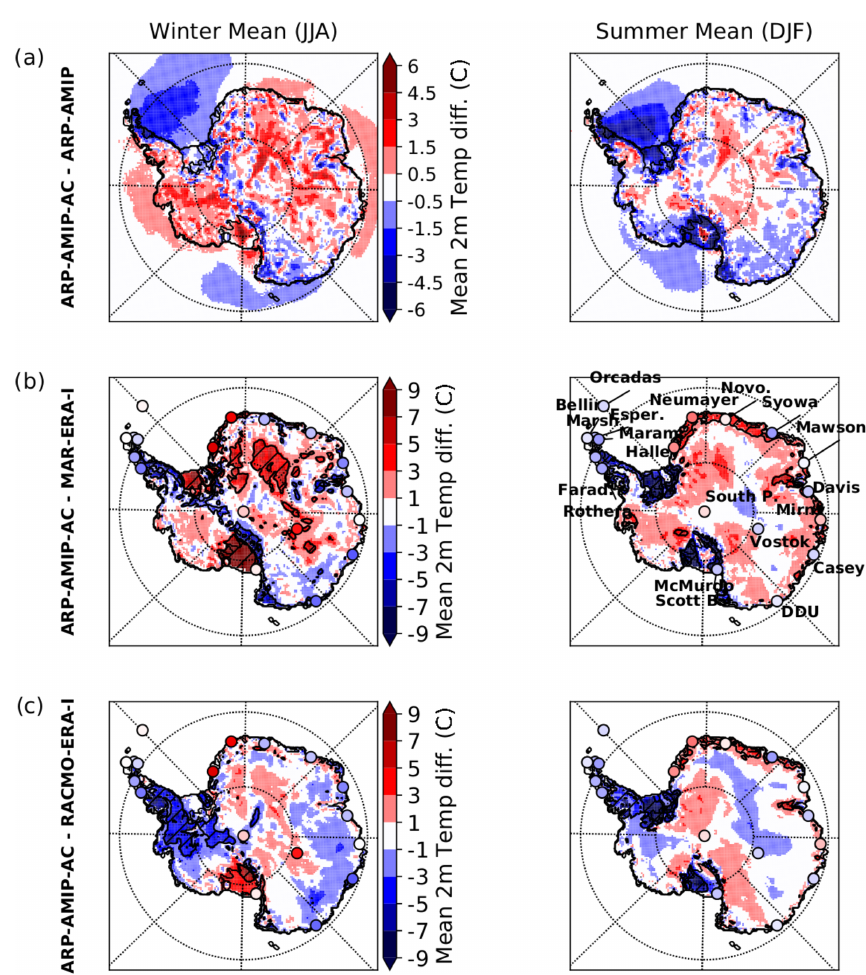
Figure 4. (a) ARP-AMIP-AC minus ARP-AMIP T 2m in winter (left) and summer (right). (b) Same as panel (a) but for ARP-AMIP-AC minus MAR-ERA-I. Circles represent mean bias for weather stations from the monthly READER database. Black contour lines represents where the difference is 1 standard deviation of MAR T 2m . (c) Same as panel (b) but for ARP-AMIP-AC minus